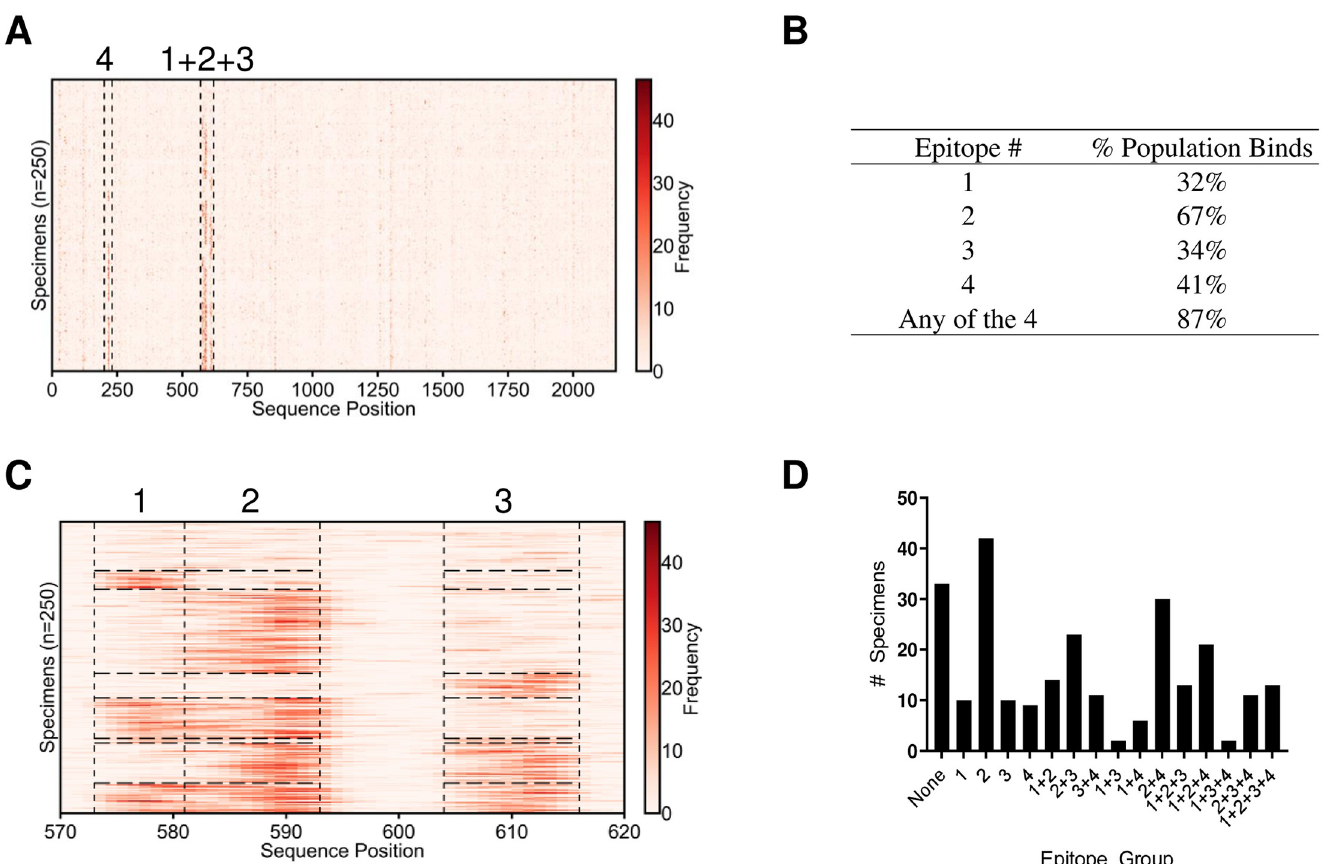
Fig 3. K-TOPE predicted four epitopes in the Rhinovirus A genome polyprotein. (A) K-TOPE was applied to the Rhinovirus A genome polyprotein (P07210) for 250 specimens. Histograms for all specimens are shown as rows in a heat map. The specimens have been clustered such that specimens that bind the same epitopes are adjacent. Regions that contain epitopes are outlined by dotted lines. (B) A table of the percentage of the population that bound each epitope. (C) The region from positions 570–620 is divided into 3 sections that correspond to distinct epitopes. These epitopes are consensus epitopes which were present in > 30% of the 250 specimens. (D) Bar graph showing membership in different epitope groups. For example, a specimen that binds epitopes 2 and 3 will belong to epitope group “2+3”. In this population, 87% of the specimens bound at least one of the consensus epitopes. The sequences of the epitopes were 1: QNPVENYI, 2: DSVLEVLVVPN, 3: APALDAAETGHT, and 4: